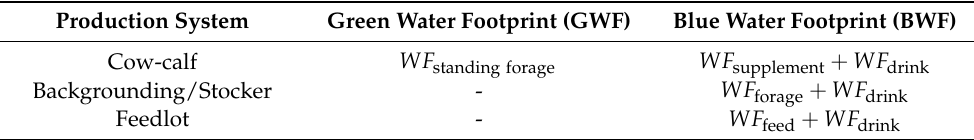
Table 1. Beef cattle water footprint scheme in New Mexico by production